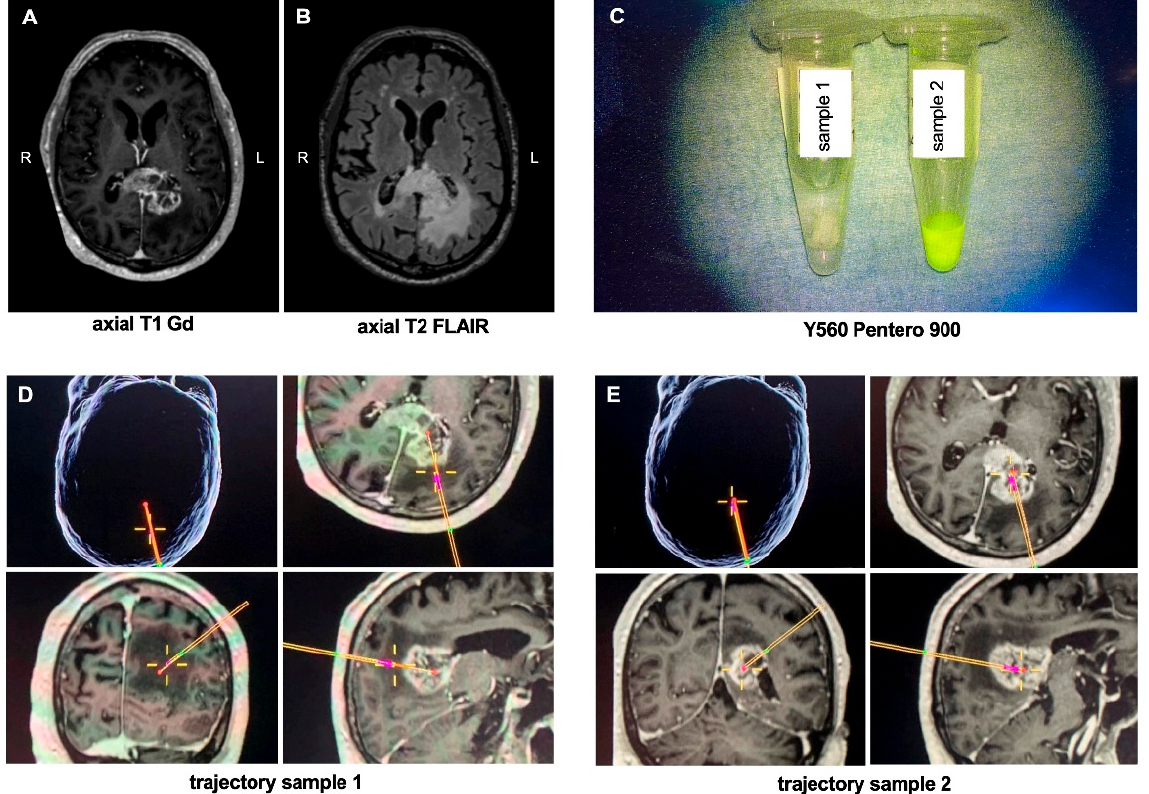
Figure 3. Illustrative case. ( A ) Axial Gadolinium-enhanced T1-weighted and ( B ) T2 FLAIR MRI of a 72-year-old patient who presented with a left-sided contrast-enhancing lesion with perifocal edema of the splenium of the corpus callosum. The patient underwent a VarioGuide ® biopsy in which a total of 8 samples were taken, of which two are exemplary shown: ( C ) image of the specimen under the Y560 filter of the Pentero 900 microscope; ( D , E ) intraoperative trajectory of the two obtained samples; sample 1 was taken from the infiltration zone of the tumor without contrast-enhancement, whereas sample 2 was obtained from tumor core. Abbreviations: Gd = gadolinium; L = left; R = right.